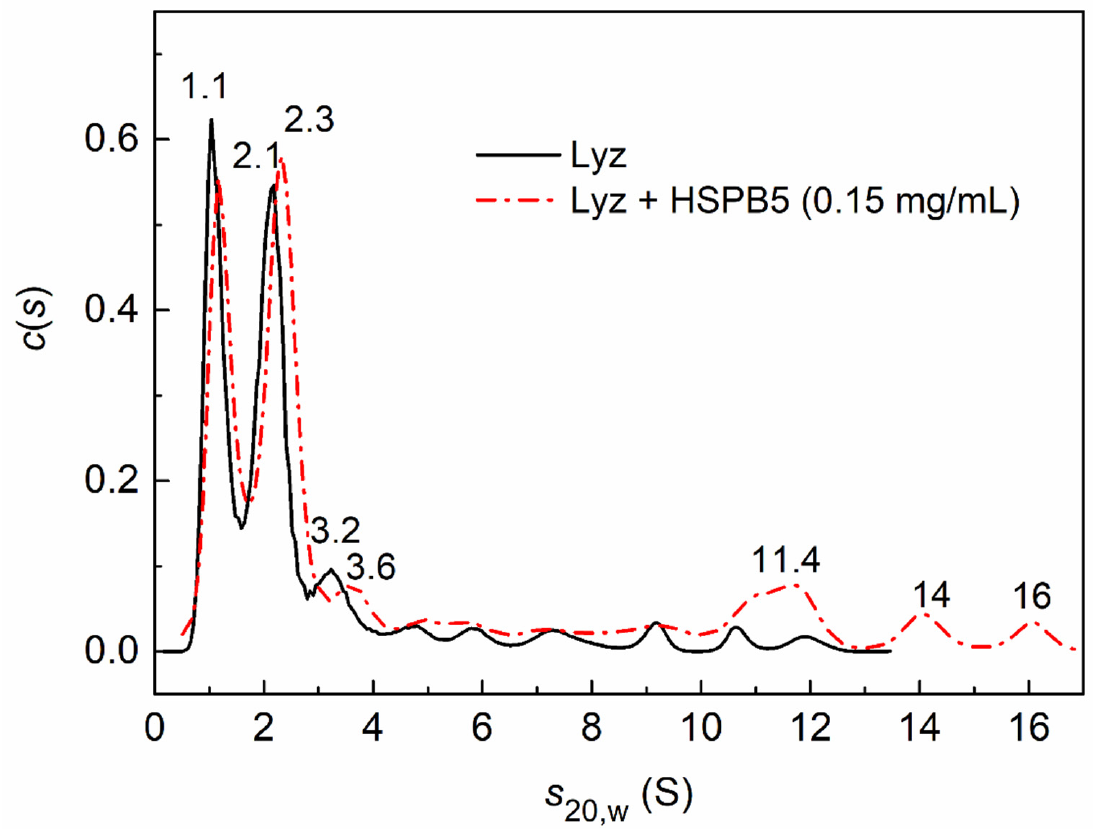
Figure 4. The sedimentation behavior of DTT-denatured Lyz (0.15 mg/mL) at 37 °C. The differential sedimentation coefficient distributions, c ( s ), for Lyz (black solid curve) and its mixture with HSPB5 (0.15 mg/mL, red dash-dotted curve) were obtained at 37 °C and corrected to standard conditions. Rotor speed was 60,000 rpm.